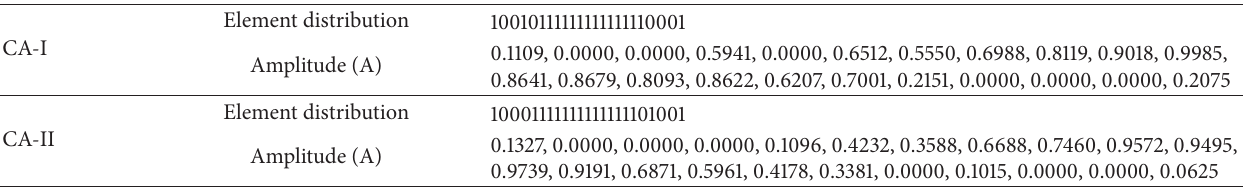
Table 5: Element distributions and optimized amplitudes of the two conformal sparse